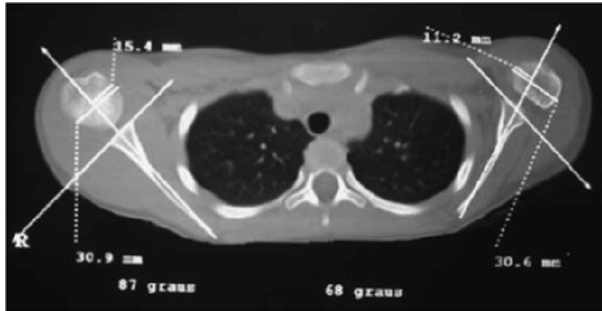
Figure 2 - Three years after the operation. Humeral head centered in the glenoid cavity and reduction of the glenoid retroversion